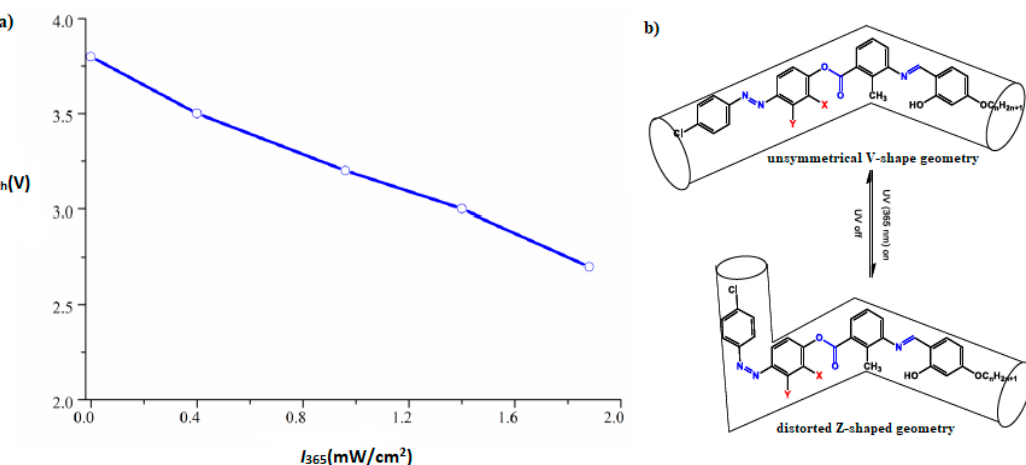
Figure 24. ( a ) The relationship between the threshold U th of electric-field-induced FT effect and the intensity of UV ( I 365 ) demonstrated by compound 65 , ( b ) trans-cis photoisomerization that brings about changes in the molecular shape of compound 65 from unsymmetrical V-shaped to distorted Z-shape (Reproduced with permission from ref. [154], copyright American Chemical Society 2020, https://doi.org/10.1021/acs.jpcc.9b09326).